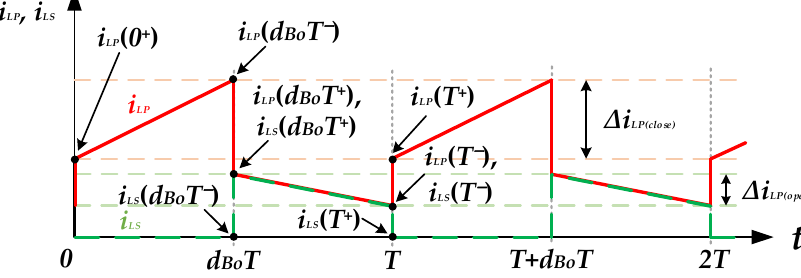
Figure 8. The current waveforms of the coupled inductor operating in CCM.